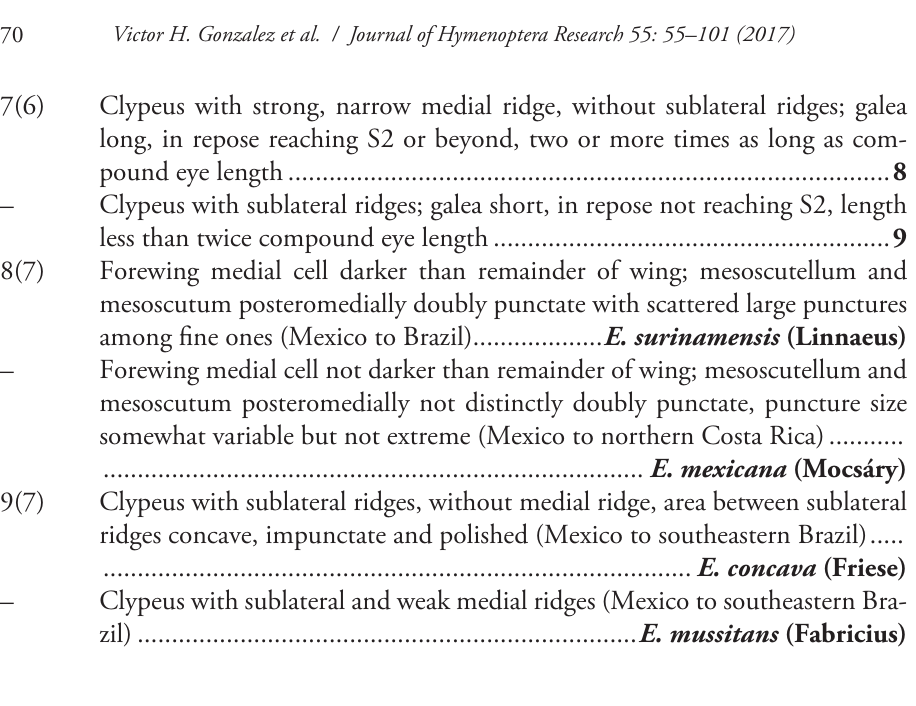
Clypeus with strong, narrow medial ridge, without sublateral ridges; galea long, in repose reaching S2 or beyond, two or more times as long as com- pound eye length ........................................................................................ 8 – Clypeus with sublateral ridges; galea short, in repose not reaching S2, length less than twice compound eye length .......................................................... 9 8(7) Forewing medial cell darker than remainder of wing; mesoscutellum and mesoscutum posteromedially doubly punctate with scattered large punctures among fine ones (Mexico to Brazil)................... E. surinamensis (Linnaeus) – Forewing medial cell not darker than remainder of wing; mesoscutellum and mesoscutum posteromedially not distinctly doubly punctate, puncture size somewhat variable but not extreme (Mexico to northern Costa Rica) ........... 9(7) Clypeus with sublateral ridges, without medial ridge, area between sublateral ridges concave, impunctate and polished (Mexico to southeastern Brazil) ..... – Clypeus with sublateral and weak medial ridges (Mexico to southeastern Bra-